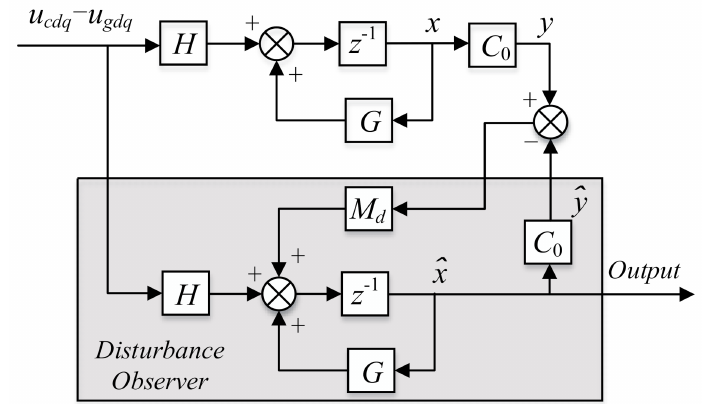
Figure 6. Structure illustration of the proposed disturbance